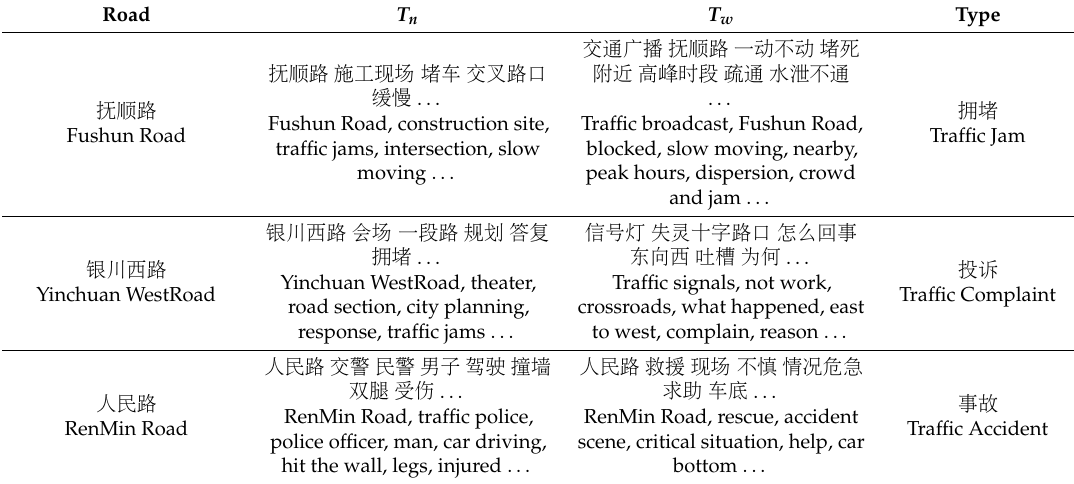
Table 4. The topic detection results from Weibo and News.